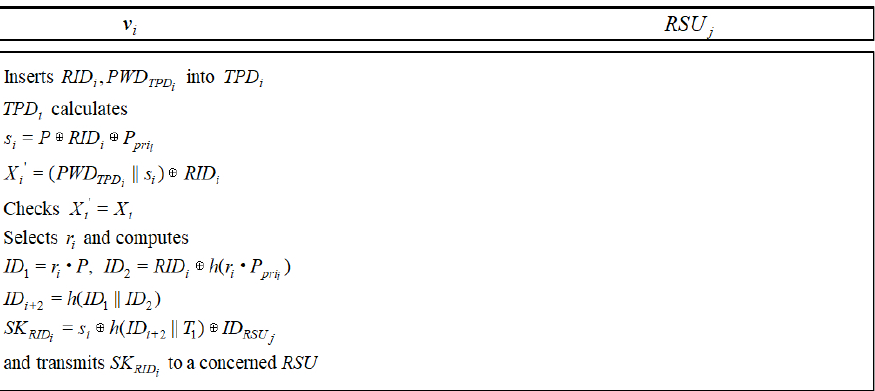
Figure 3. Key generation phase of Limbasiya et al.’s